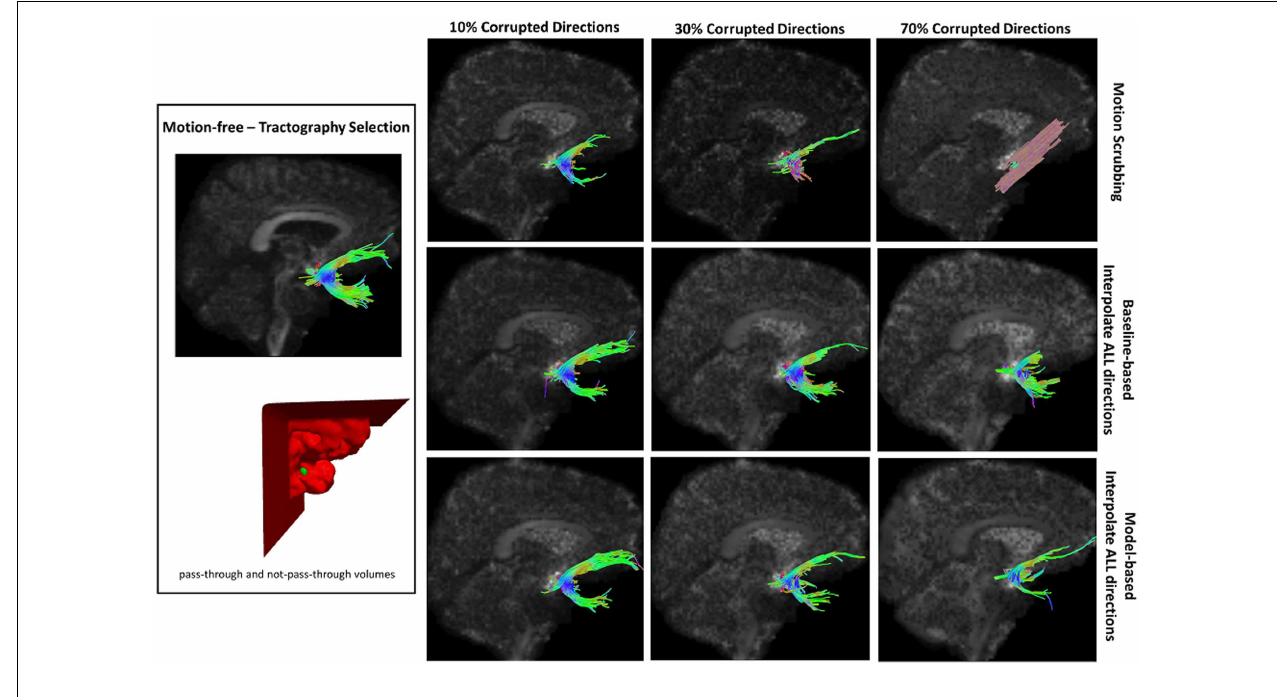
outlier-based (i.e., motion scrubbing) and registration-based (using baseline and model-based reference volumes). Notice the inaccurate UNC tract being detected from the motion scrubbing choice at high percentages of motion